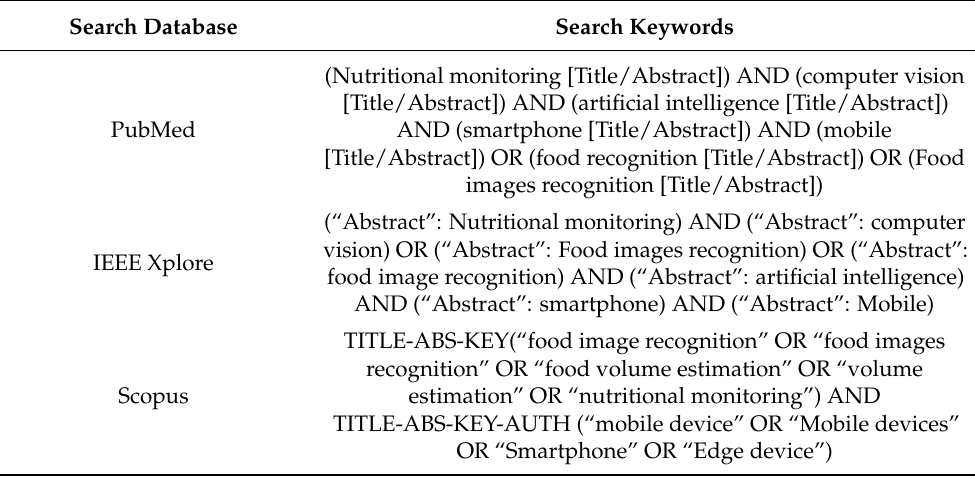
Table 2. Queries used for the selected search